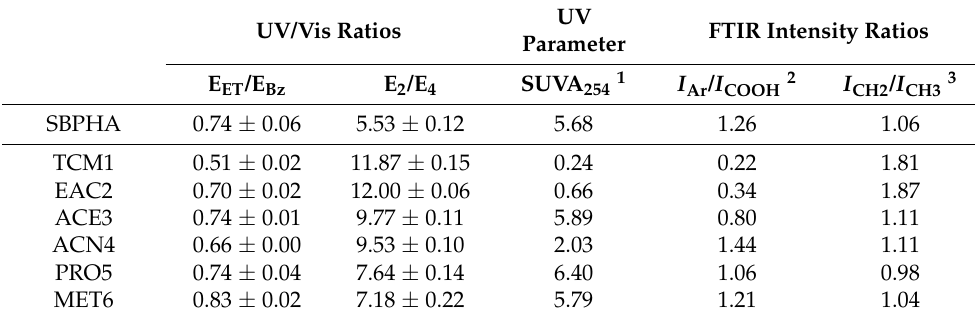
UV FTIR Intensity Ratios Parameter